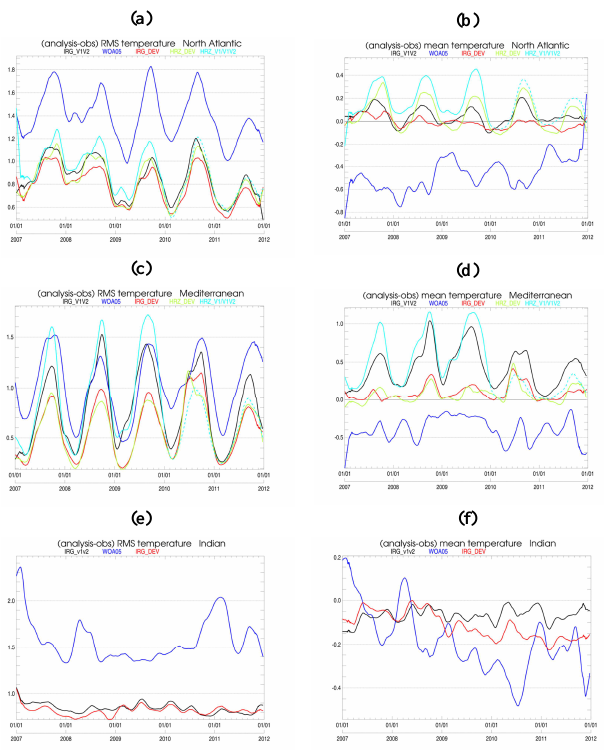
Fig. 8. Same as Fig. 7 but for Salinity (psu).